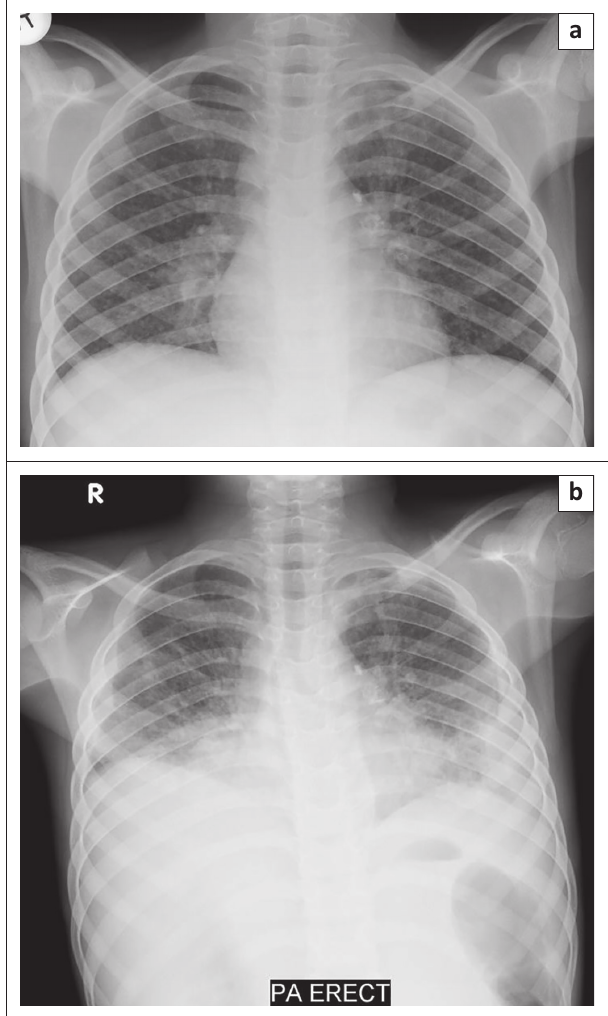
FIGURE 5: 1-year-old boy with HIV infection, severe immunosuppression and recent diagnosis of TB. (a) Frontal chest radiograph obtained while receiving HAART, shows right paratracheal and hilar adenopathy as well as diffuse small nodular opacities in both lungs. (b) Frontal chest radiograph obtained 3 weeks later demonstrates worsening mediastinal adenopathy and nodular lung opacities as well as interval development of bilateral pleural effusions despite viral suppression and improved CD4 count. Typical imaging feature of TB IRIS in children with HIV